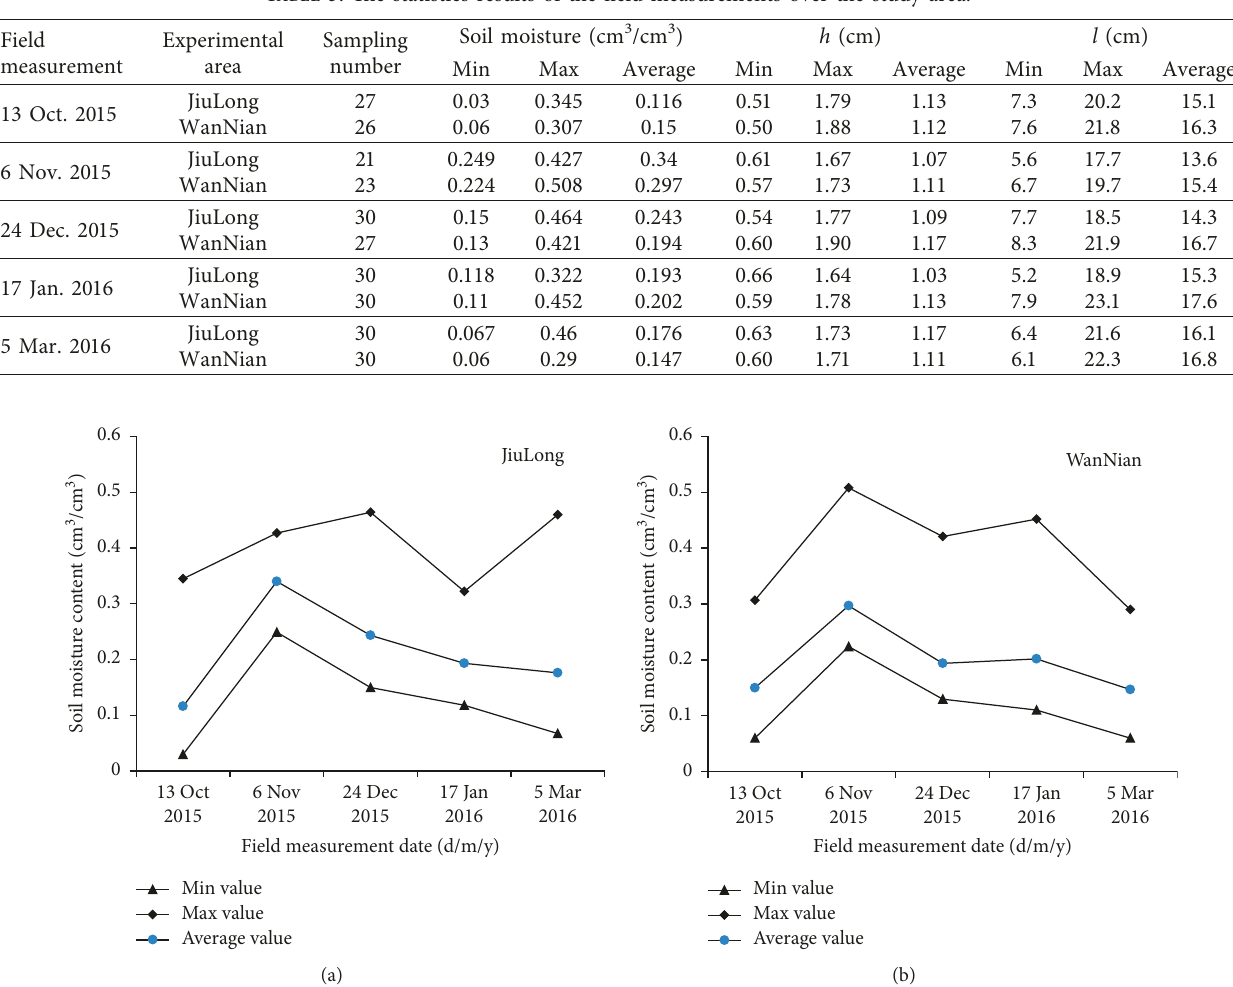
Figure 3: Statistics graphs of the time series soil moisture measurements. (a) JiuLong experimental area. (b) WanNian experimental